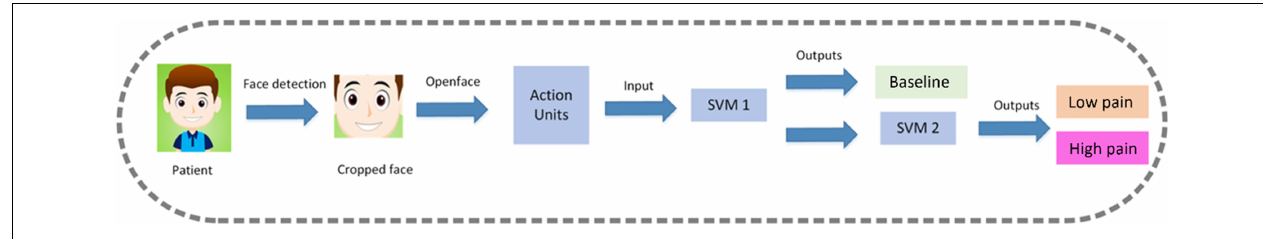
FIGURE 3 | The proposed classification tree for the three pain levels.